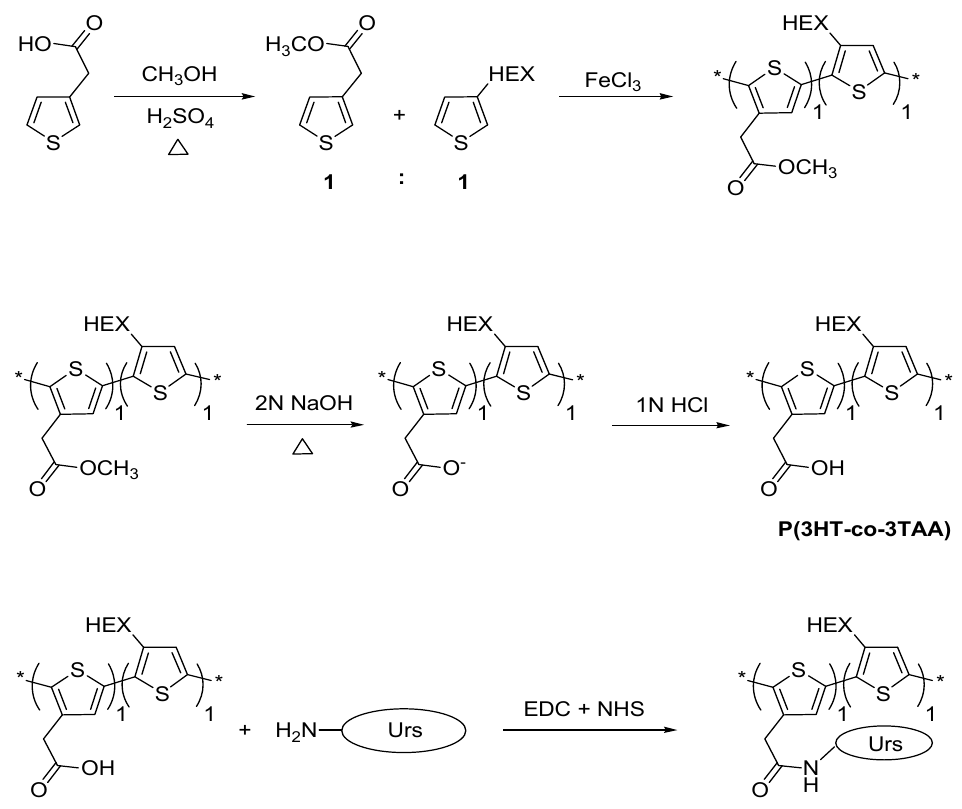
Scheme 1. Synthesis of poly(3-hexylthiophene- co -3-thiopheneacetic acid 1:1) (P(3HT- co -3TAA)) functionalization and its functionalization with urease (Urs) by formation of a peptide